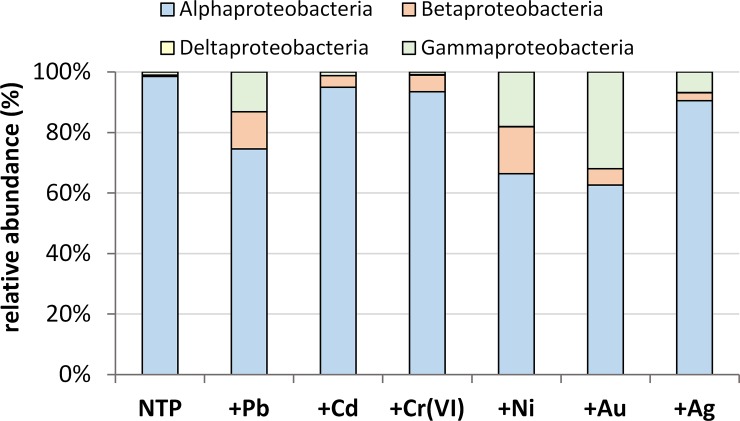
Decomposition of proteobacteria on 4 classes in analysed samples.